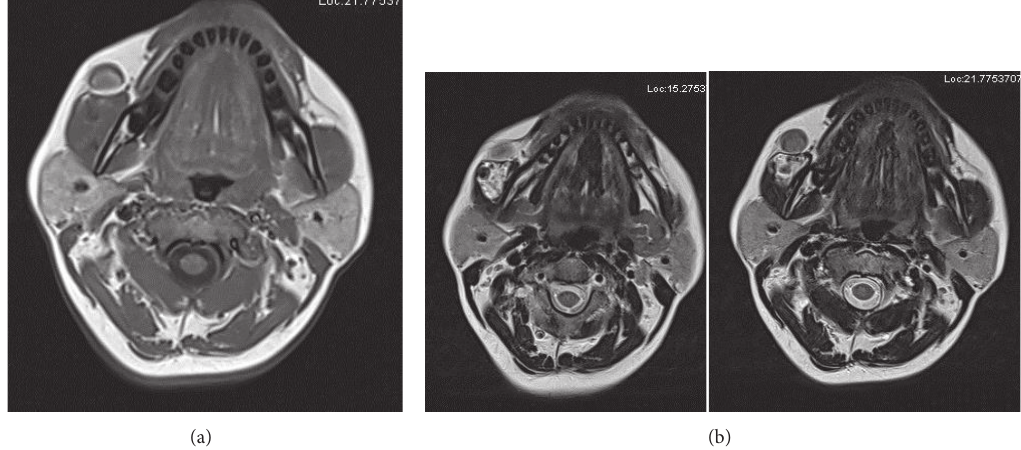
Figure 8: (a) Magnetic resonance imaging discloses isointense mass on T1-weighted MR image. (b) Isointense mass on T2-weighted